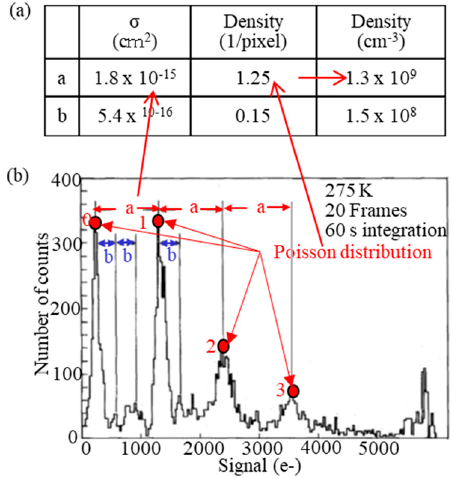
Figure 4. Dark current spectroscopy [16]. ( a ) Obtained capture cross sections and metal densities. ( b ) Dark current histogram, having two series of specific and periodic peaks, labeled as ( a ) and ( b ).